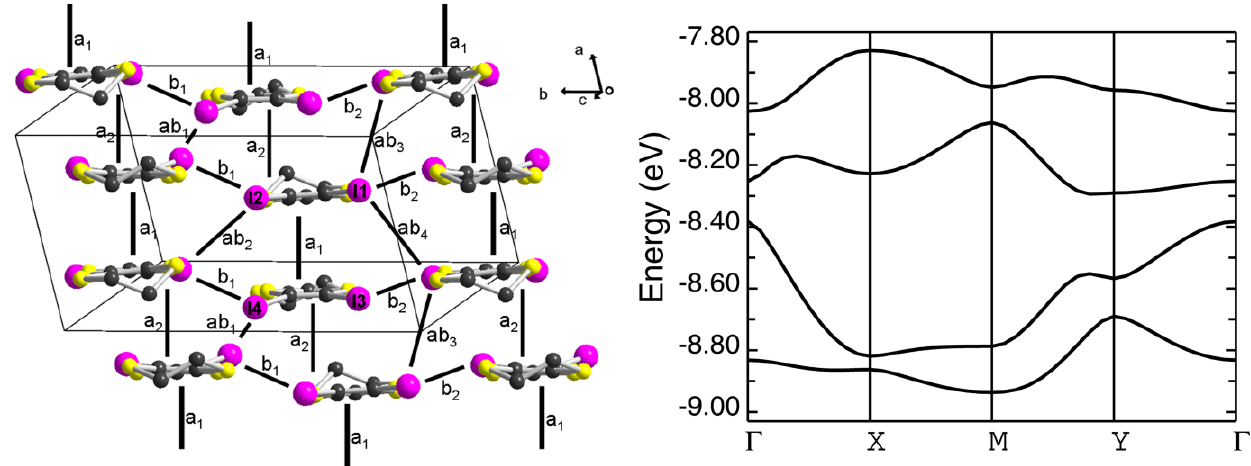
Figure 7. Temperature dependence of the resistivity of the mixed-valence salt ( 2 )